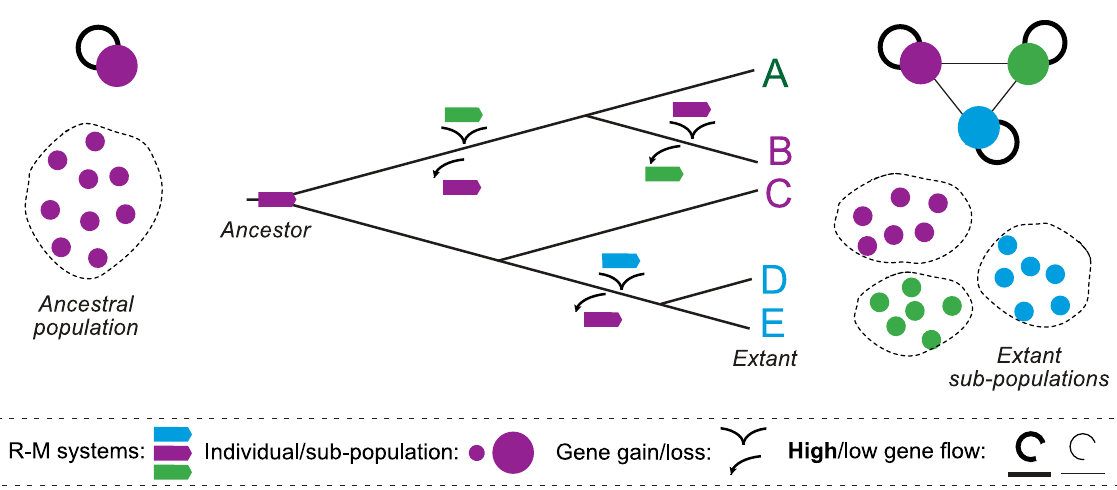
Fig 3. Diversification of R–M systems changes gene flow within species. When a population has a single R–M system (left), HGT between cells is not affected by restriction. As the diversity of systems increases (phylogenetic tree at the center), the subpopulations of individuals with similar R–M systems exchange genes at higher rates (high flow) than those with different R–M systems (low gene flow, right top), leading to fragmentation of gene flow in populations (right bottom). HGT, horizontal gene transfer; R–M,